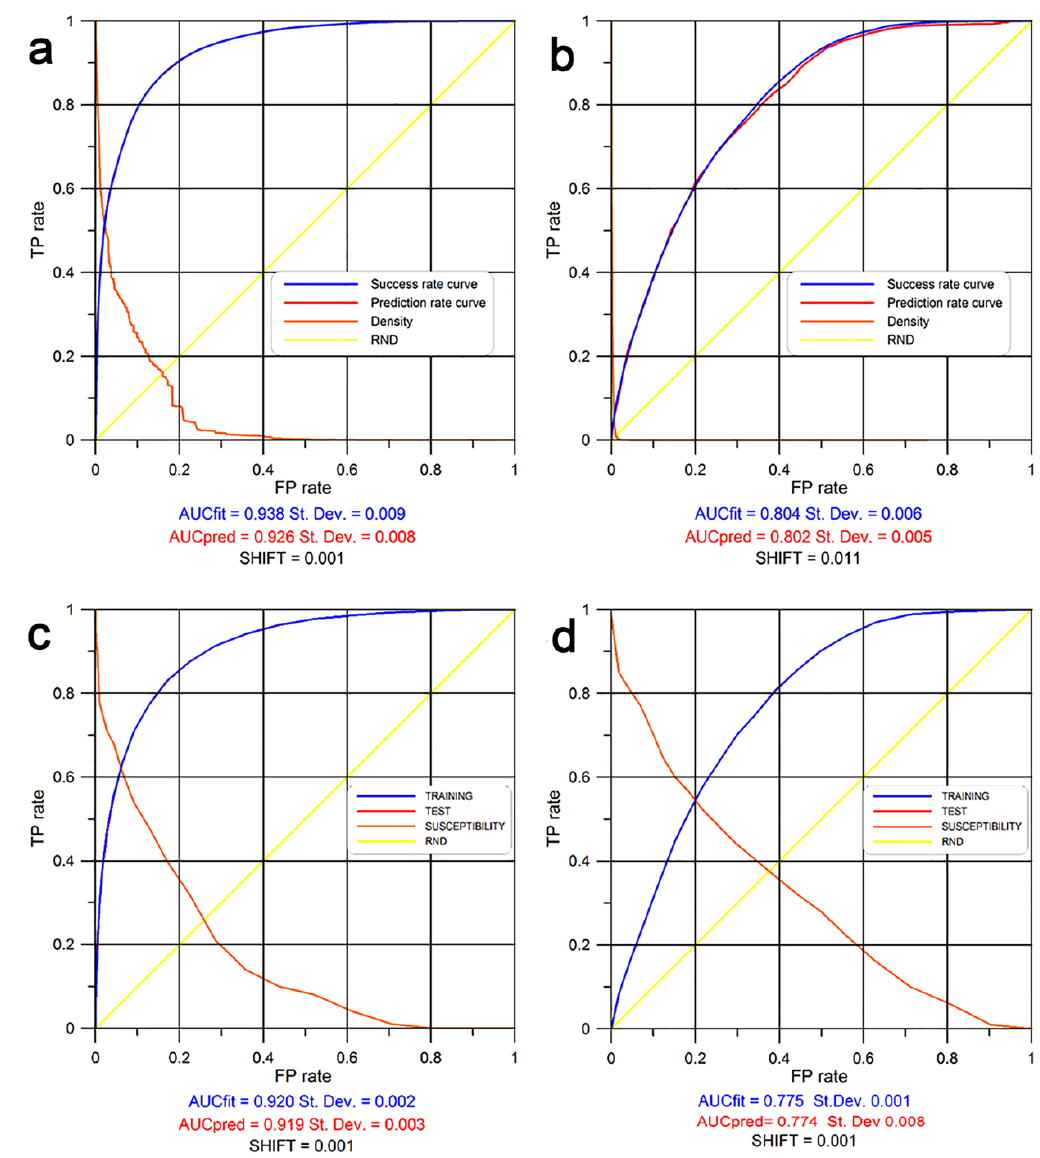
Figure 4. Receiver operating characteristic (ROC) curves: ( a ) conditional analysis (CA) for scarp landslide (SCR_LSN); ( b ) CA for hillslope landslide (HILL_LSN); ( c ) binary logistic regression (BLR) analysis for SCR_LSN; ( d ) BLR analysis for HILL_LSN.